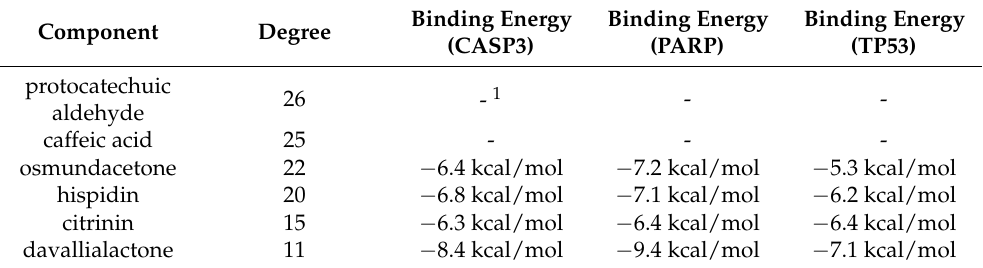
Table 2. Degree of active components and binding energy of docking with CASP3, PARP, TP53. Component Degree